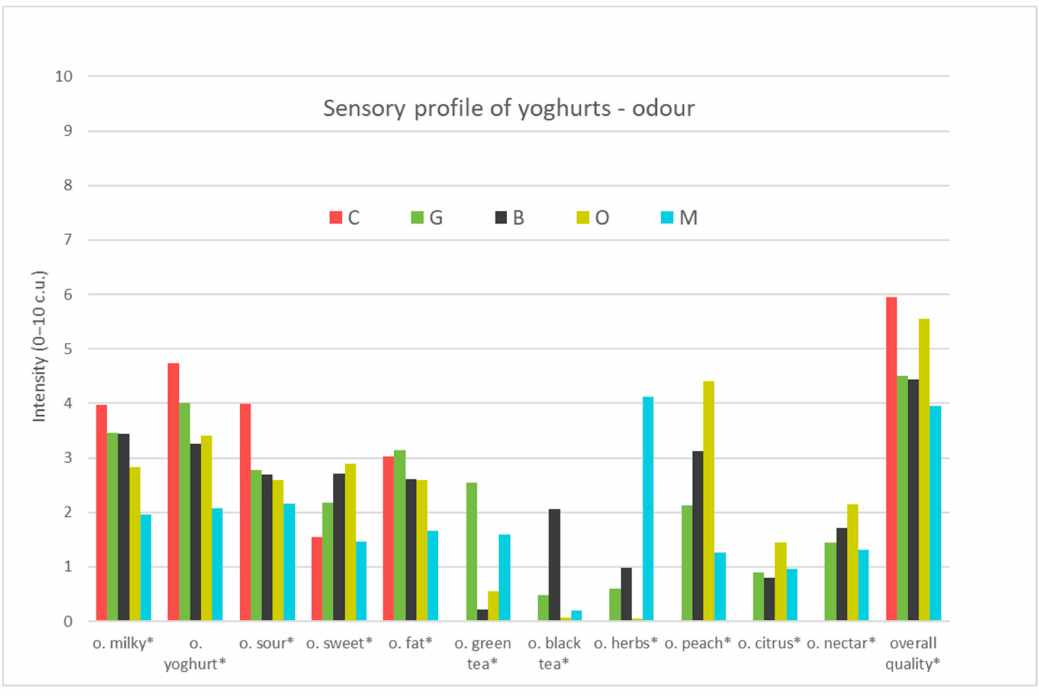
Figure 1. The sensory quality profile of yoghurt samples (odour). C—Control, G—Green tea, B—Black